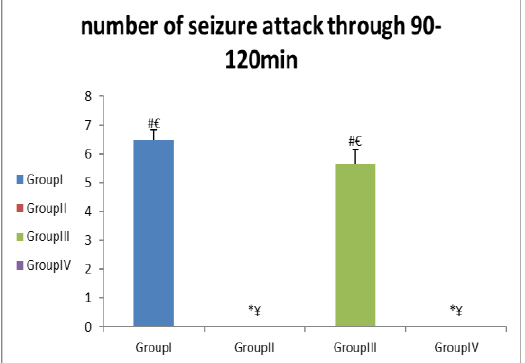
Figure 4. Mean±SE of the number of clonic seizures at 90-120min that induced by yohimbine HCl (Group I) and other treated groups (Diazepam+ yohimbine HCl(Group II), omega 3 fatty acids +yohimbine HCl (Group III) and omega 3 fatty acids +Diazepam +yohimbine HCl (Group IV). Symbol *refers to difference between group I and other groups. Symbol; # refers to difference between group II and other groups; symbol ¥ refers to difference between group III and other groups; and symbol € refers to difference between group IV and other